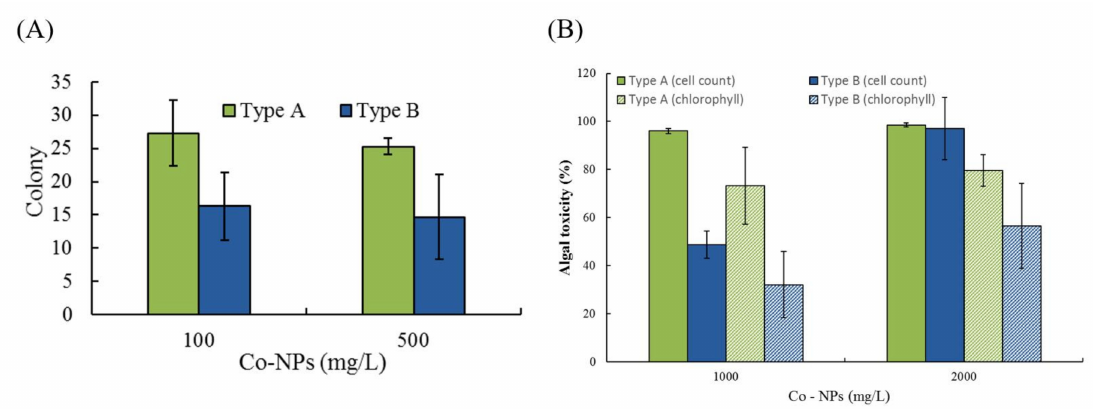
Figure 8. Comparisons of the toxic e ff ects of the di ff erent sizes of Co-NPs: ( A ) on the colonies formed by reverse mutation, ( B ) on the two endpoints (cell count and chlorophyll content) of algal